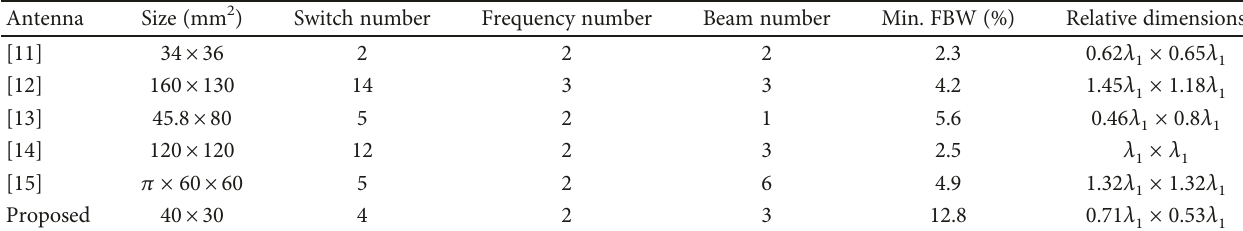
Figure 12: Measured radiation patterns in yz , H-plane. (a) Modes 1 – 3. (b) Modes 4 – 6. Table 2: Performance of frequency- and pattern-recon fi gurable